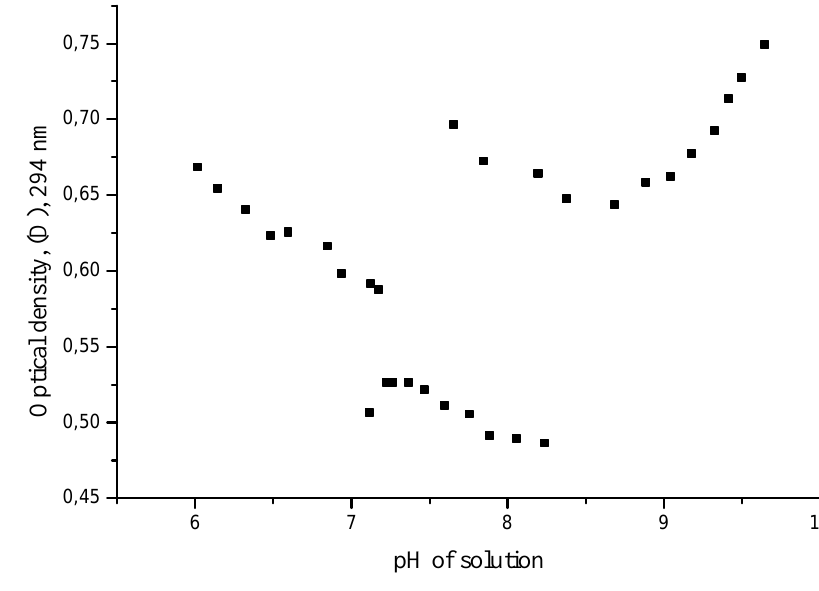
Figure 1. Variations of optical densities of quercetin solution at wavelength 294 ± 2 nm in result of its slow stepwise titration by NaOH within the pH range 6-10. The anomaly at pH 7.2-7.1 is caused by the interruption of the process for ca . 30 min; the second one (at pH 8.2-7.7) was obtained after the storage of the solution during one